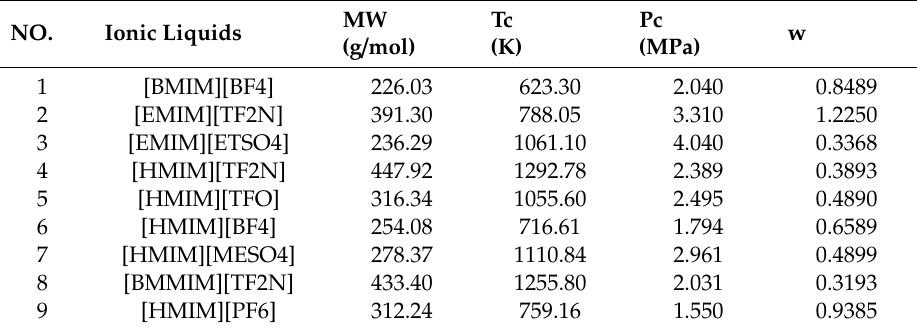
Table 1. Critical parameters of imidazolium ionic liquids.